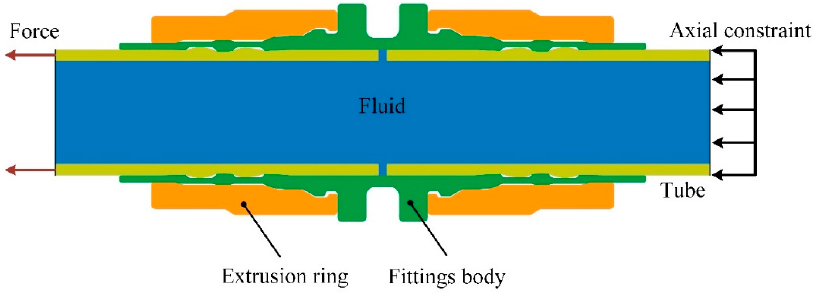
Figure 2. The principle of connection-strength experiment.